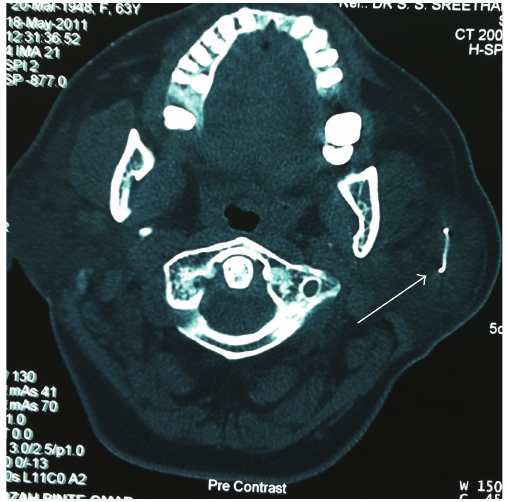
Figure 1: CT scan showing a linear calcification in the substance of the parotid gland (arrow).